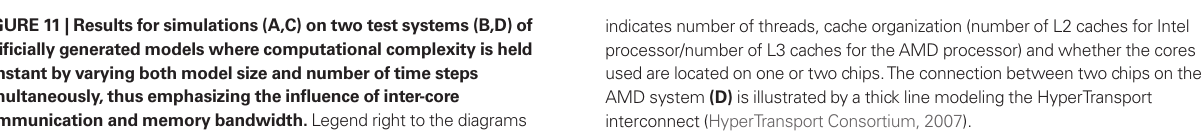
FIGURE 11 | Results for simulations (A,C) on two test systems (B,D) of artifi cially generated models where computational complexity is held constant by varying both model size and number of time steps simultaneously, thus emphasizing the infl uence of inter-core communication and memory bandwidth. Legend right to the diagrams